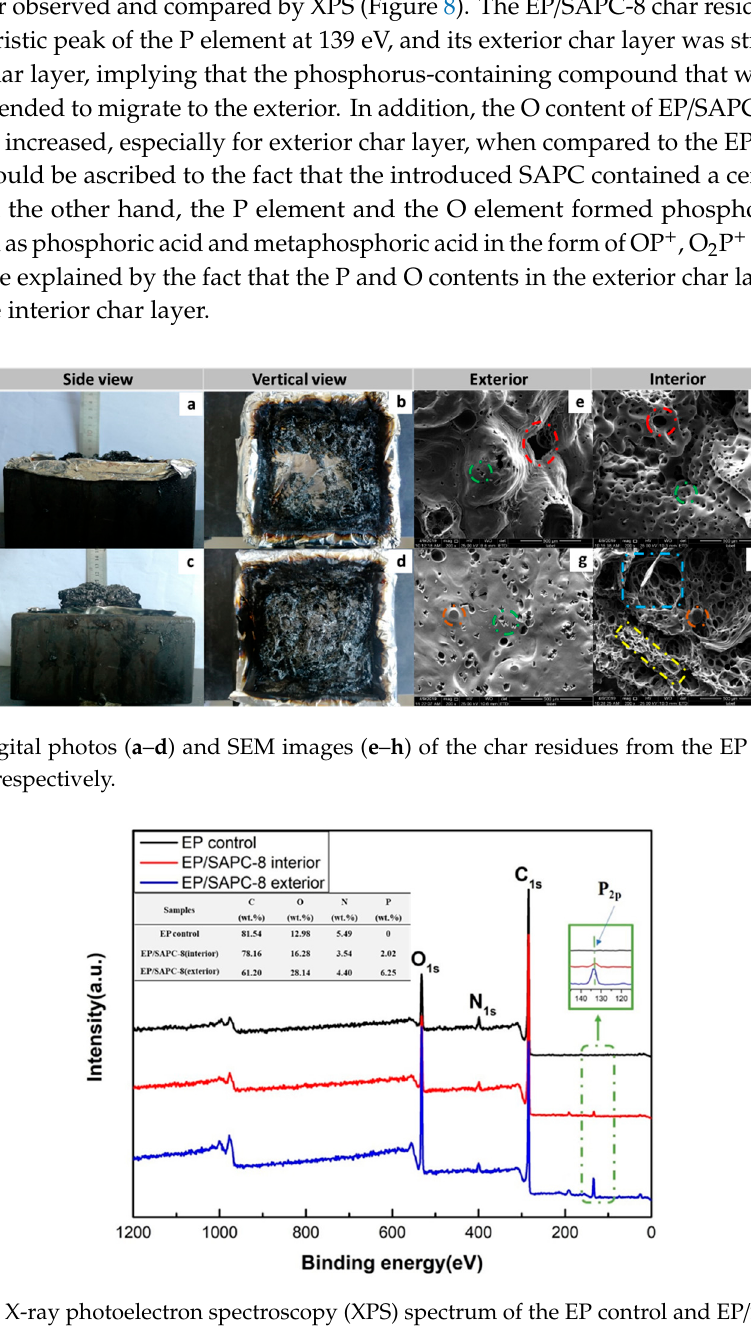
Figure 8. X-ray photoelectron spectroscopy (XPS) spectrum of the EP control and EP/SAPC-8.